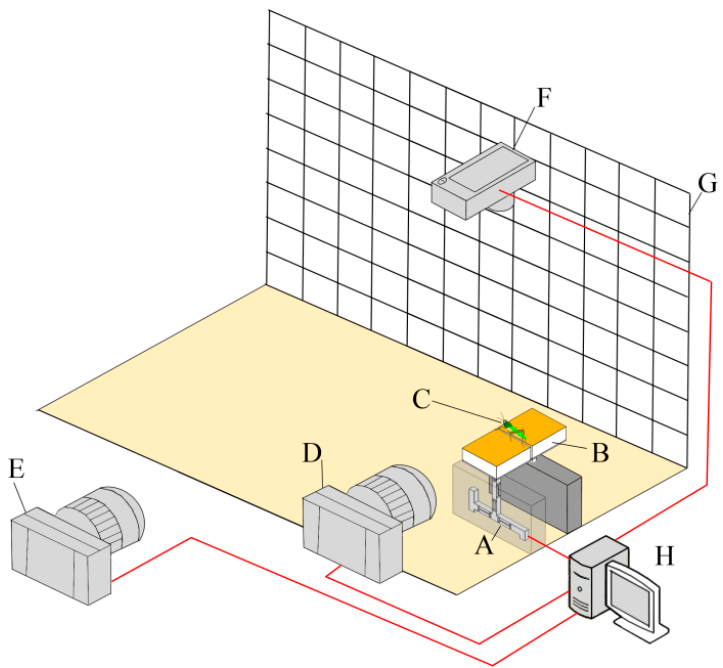
Figure 1. A custom-developed test system for measuring the kinematics and reaction force of adult locusts while jumping. ( A ) Three-dimensional high-precision force sensor; ( B ) two platforms, one of which is fixed to the force sensor and the other fixed to a stand column; ( C ) adult locust whose left and right hind legs each stood on one platform; ( D ) a high-speed camera for obtaining the rapid movement of the hind leg during the jump; ( E ) a high-speed camera for obtaining the trajectory of the locust jump; ( F ) a video camera for imaging the posture of the locust from above; ( G ) a coordinate background plate; and ( H ) desktop computer for data acquisition.